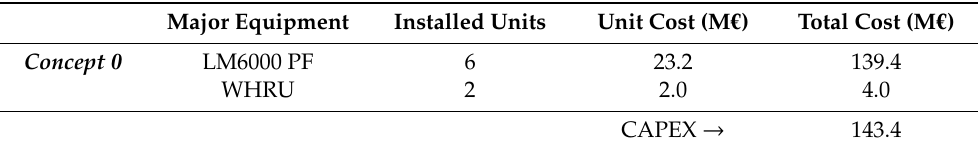
Table 2. CAPEX breakdown for Concept 0